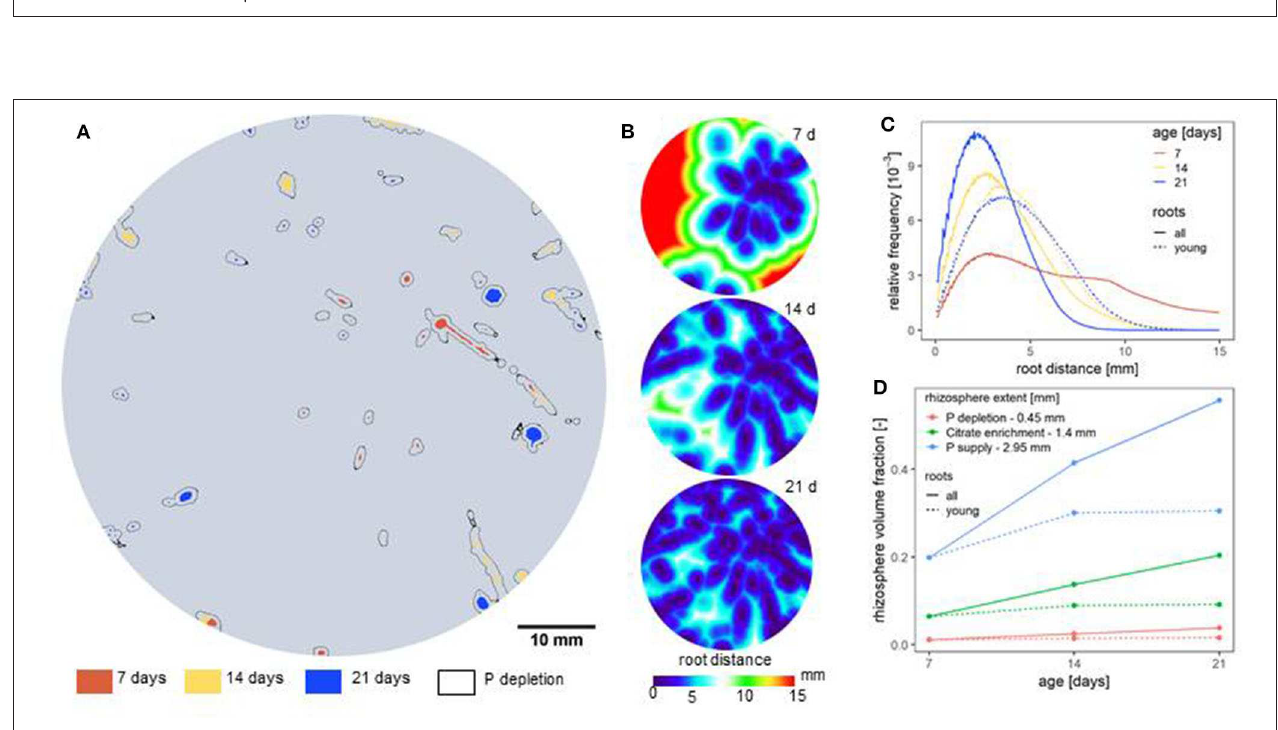
FIGURE 5 | (A) Root distribution within a 2D cross section at 10cm depth through a soil column planted with Zea mays . Roots of different age are distinguished by color. Root age was derived by registration of X-ray CT scans from different time points to each other. (B) Euclidean distance maps based on 3D X-ray CT scans for the cross section in (A) ; distance maps are provided for three time points, i.e., 7, 14, and 21 days after planting. (C) Frequency distributions of root distances in soil at three time points. Continuous lines refer to all roots present at the respective time point, dotted lines refer to young roots only for the hypothetical case, that only those are active. (D) Based on distance maps the rhizosphere volume was calculated for rhizosphere width defined in de Parseval et al. (2017) for P depletion, citrate enrichment and the P supply zone. Depending on the state variable and time point rhizosphere soil fraction accounted for 1–50% of total volume.